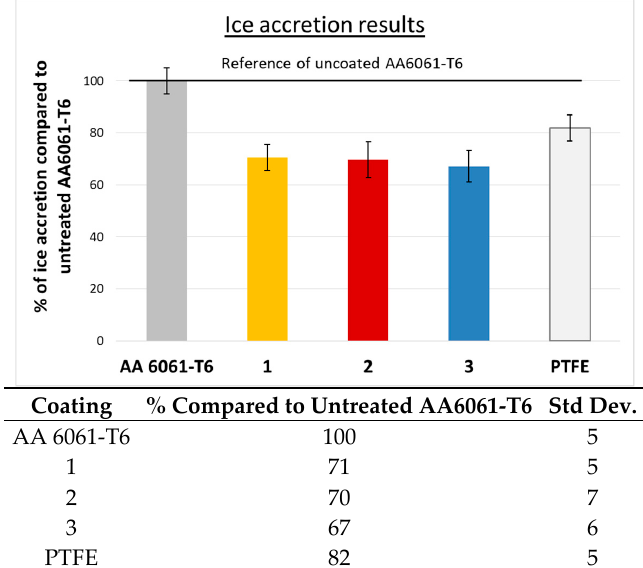
Figure 6. Mean values and standard deviation after 6 ice accretion cycles for all the studied coatings.